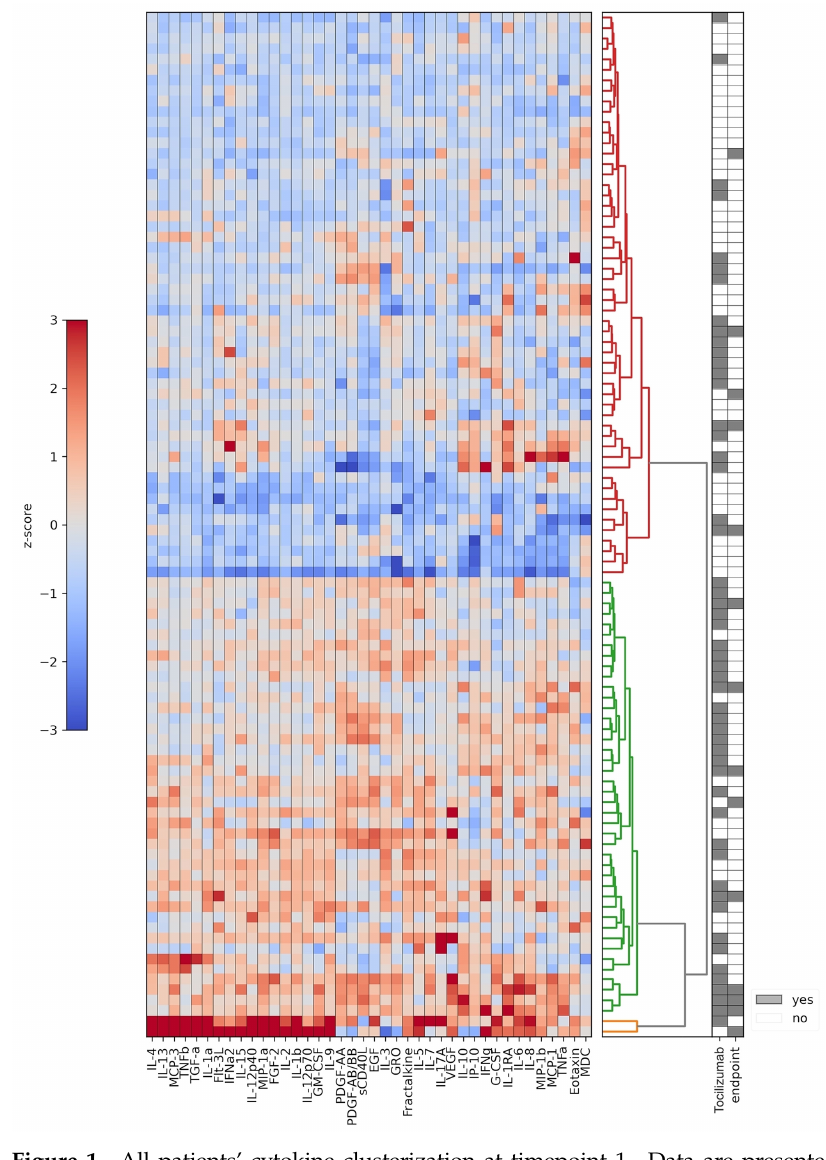
Figure 1. All patients’ cytokine clusterization at timepoint 1. Data are presented as log 2 of the normalized fluorescence intensity values that were further z-score normalized and used as a basis for hierarchical clustering analysis. Cluster 1 is indicated with the red hierarchical tree, cluster 2 is indicated with the green hierarchical tree, orange color indicates two outliers that were excluded from the further analysis. Tocilizumab indicates application of the immunomodulatory therapy. Endpoint indicates a presence of a combined clinical endpoint, which included application of high-flow oxygen therapy or noninvasive/invasive lung ventilation, patient transfer to intensive care, and in-hospital